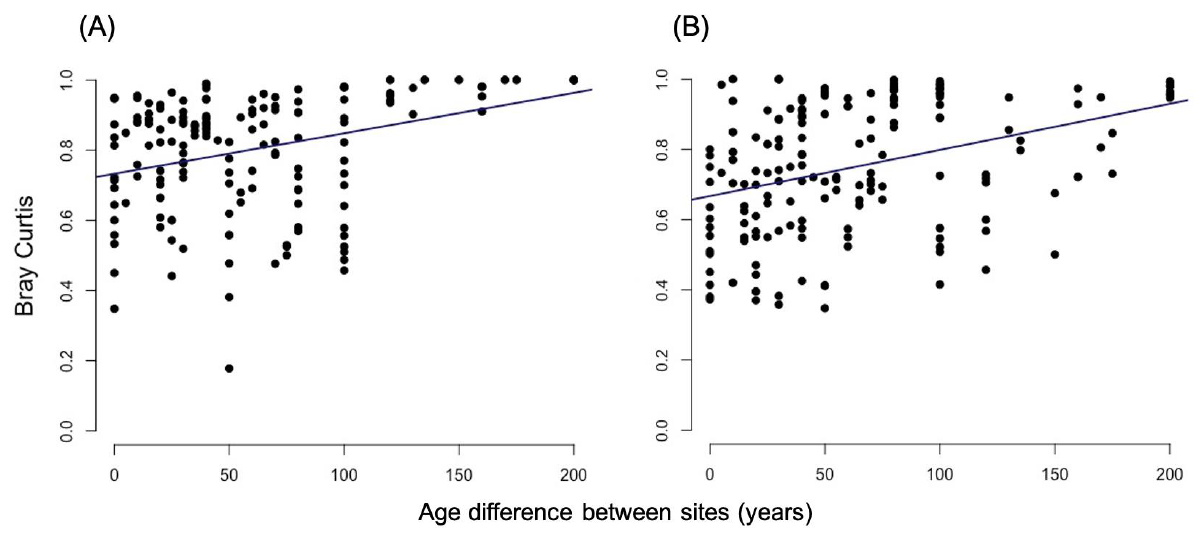
Figure 5. Results from a 0.5 quantile regression of Bray-Curtis and age difference between site pairs for field data ( A ) and for remote sensing data ( B ).